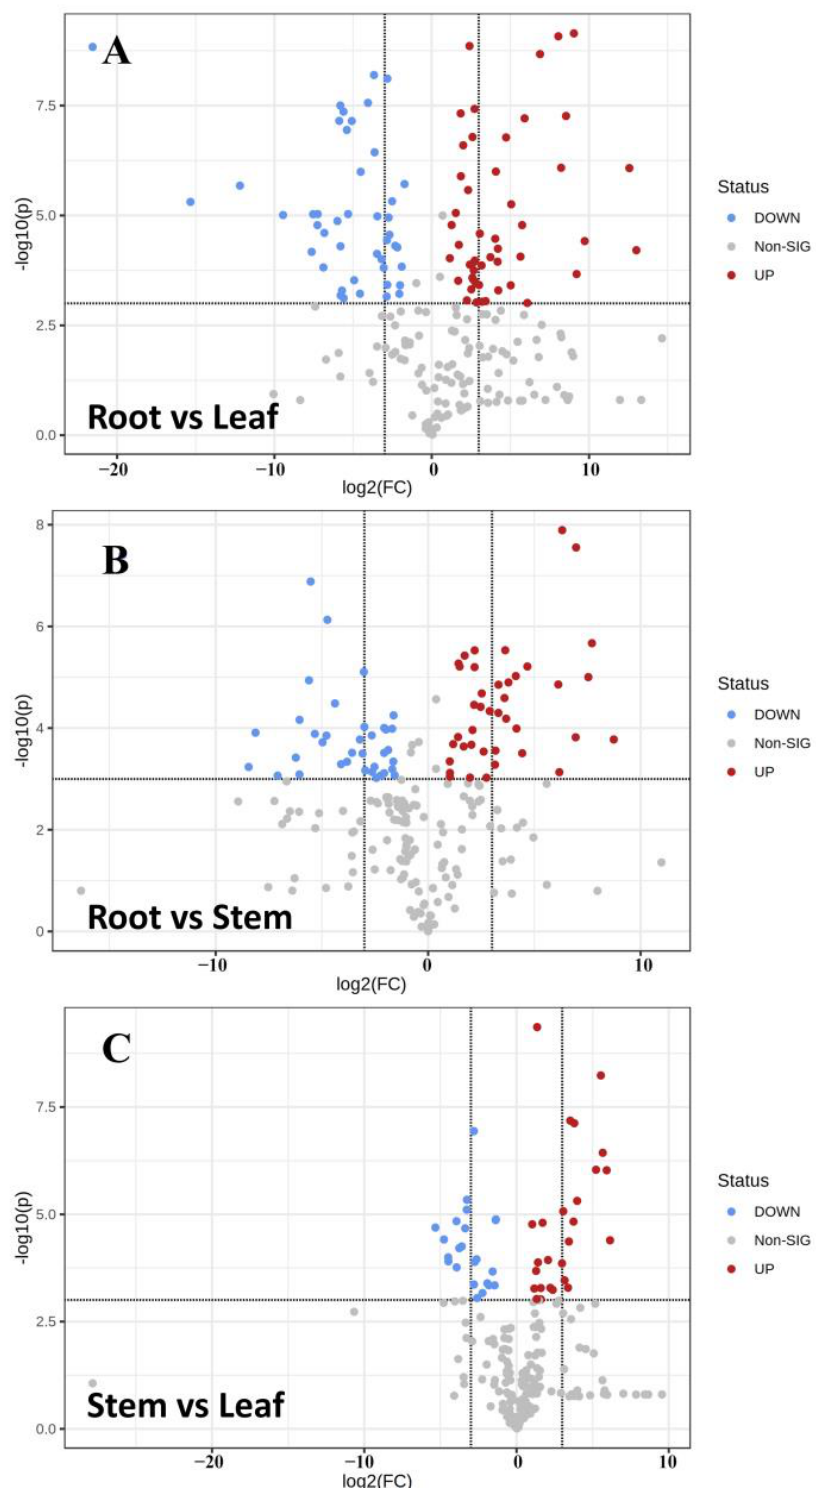
Figure 7. Volcanic map of differential metabolites in different parts of Houttuynia cordata . ( A ) Root vs. leaf; ( B ) root vs. stem; ( C ) stem vs. leaf. The abscissa represents the sample name, and the ordinate represents the differential metabolite. The color from blue to red indicates the expression abundance of metabolites from low to high, that is, the redder the color, the higher the expression abundance of differential metabolites. Table 1. Statistical table of the number of metabolites in different parts of Houttuynia cordata .